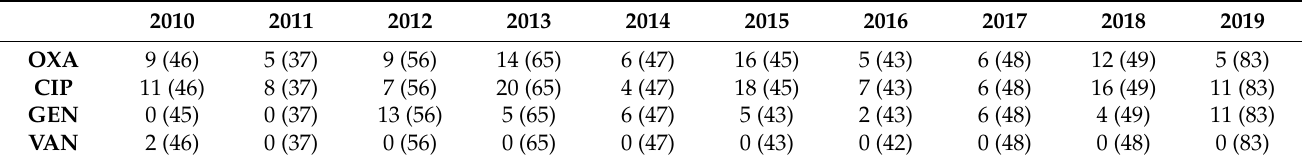
Table 11. Resistance of Staphylococcus aureus to antibiotics at the Department of Anesthesiology and Intensive Care Medicine in 2010–2019.